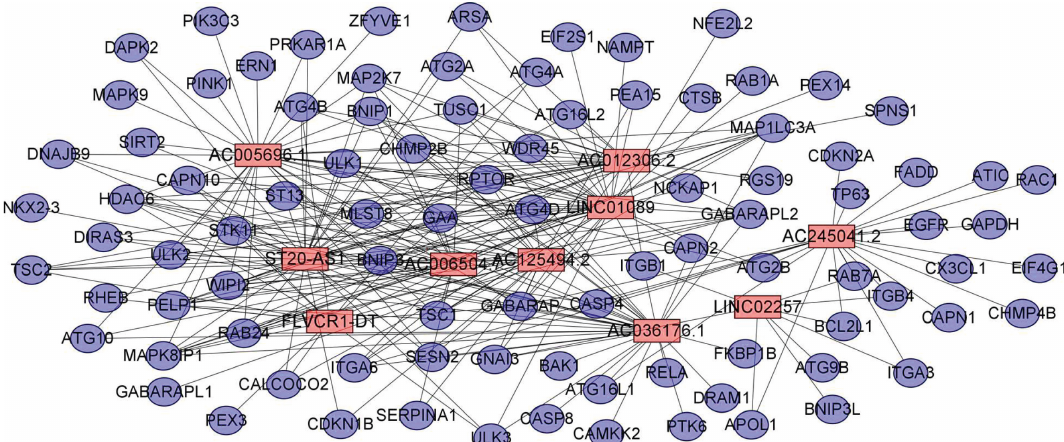
Figure 2: Coexpression network for autophagy-related genes and ten independently diagnosed lncRNAs. The red rectangular nodes represent independently diagnosed lncRNAs, and the blue and purple round nodes represent autophagy-related genes.